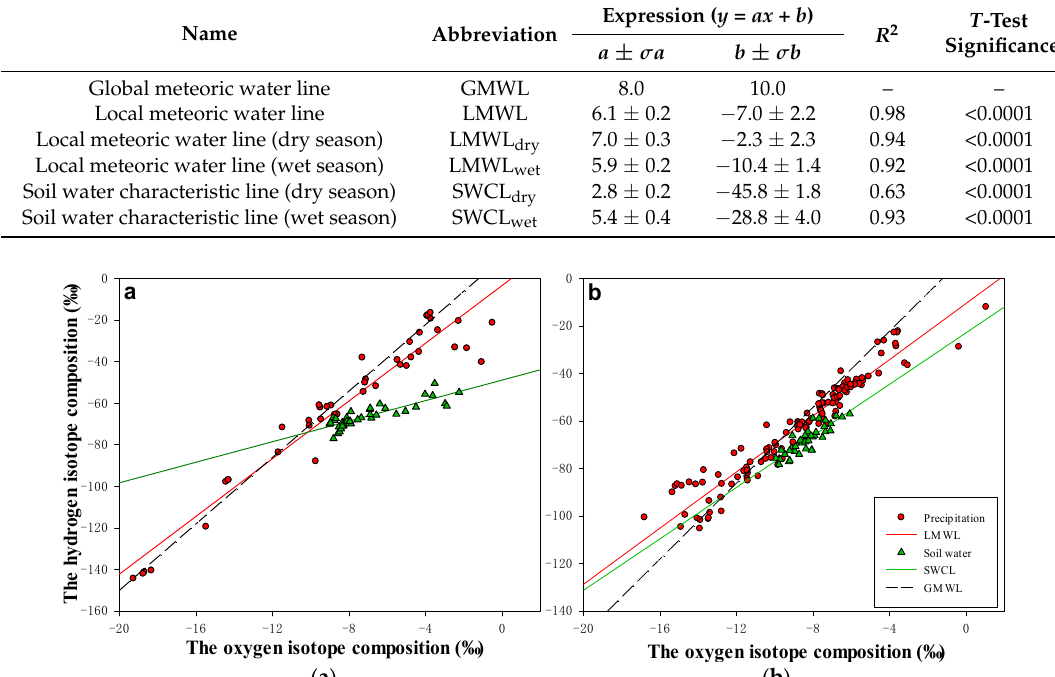
Figure 4. Seasonal variation in d –excess. 3.3. The Relationship of the Isotopic Composition of Precipitation with the Amount of Precipitation and Temperature The regression results for the monthly total amount (hereafter as A ) of precipitation, with respect to its monthly mean isotopic value, were represented by δ 2 H = − 0.16 A − 53.76 ( R 2 = 0.67, F = 15.8, p = 0.0008) and δ 18 O = − 0.02 A − 8.87 ( R 2 = 0.67, F = 15.6, p = 0.0008) (Figure 5a). The values of δ 2 H and δ 18 O became lighter with increasing amounts of precipitation. Reduced rates of − 15‰ in δ 2 H and − 2‰ in δ 18 O per 100 mm of precipitation were obtained from the slope of the regression equations. The linear regressions for the monthly mean temperature (hereafter as T ), with respect to the monthly mean isotopic value, were represented by δ 2 H = − 1.60 T − 39.61 ( R 2 = 0.64, F = 31.9, p < 0.0001) and δ 18 O = − 0.20 T − 6.82 ( R 2 = 0.64, F = 30.9, p < 0.0001) (Figure 5b), which indicated that the values of δ 2 H and δ 18 O decreased with increasing temperature. The multiple linear regression results of isotopic values, amount of precipitation and temperature ( δ 2 H = − 0.05 A − 1.3 T − 40.64, R 2 = 0.67, p < 0.001; A : p = 0.26; T : p = 0.04. δ 18 O = − 0.01 A − 1.8 T − 7.0, R 2 = 0.67, p < 0.001; A : p = 0.25; T : p = 0.04), also demonstrated a negative relationship between the isotopic values and the amount of precipitation/temperature. Lee and Kim had a similar finding in their research about the relationship between the isotopic composition and temperature in the upper North Han River basin [16]. Date 2011/01/01